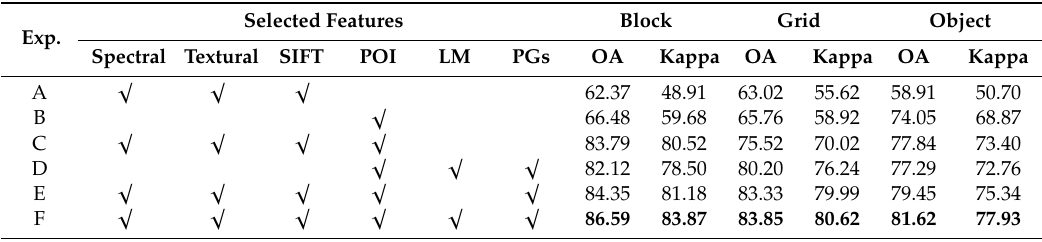
Di ff erent combinations of attribute categories with di ff erent segmentation (OA: overall